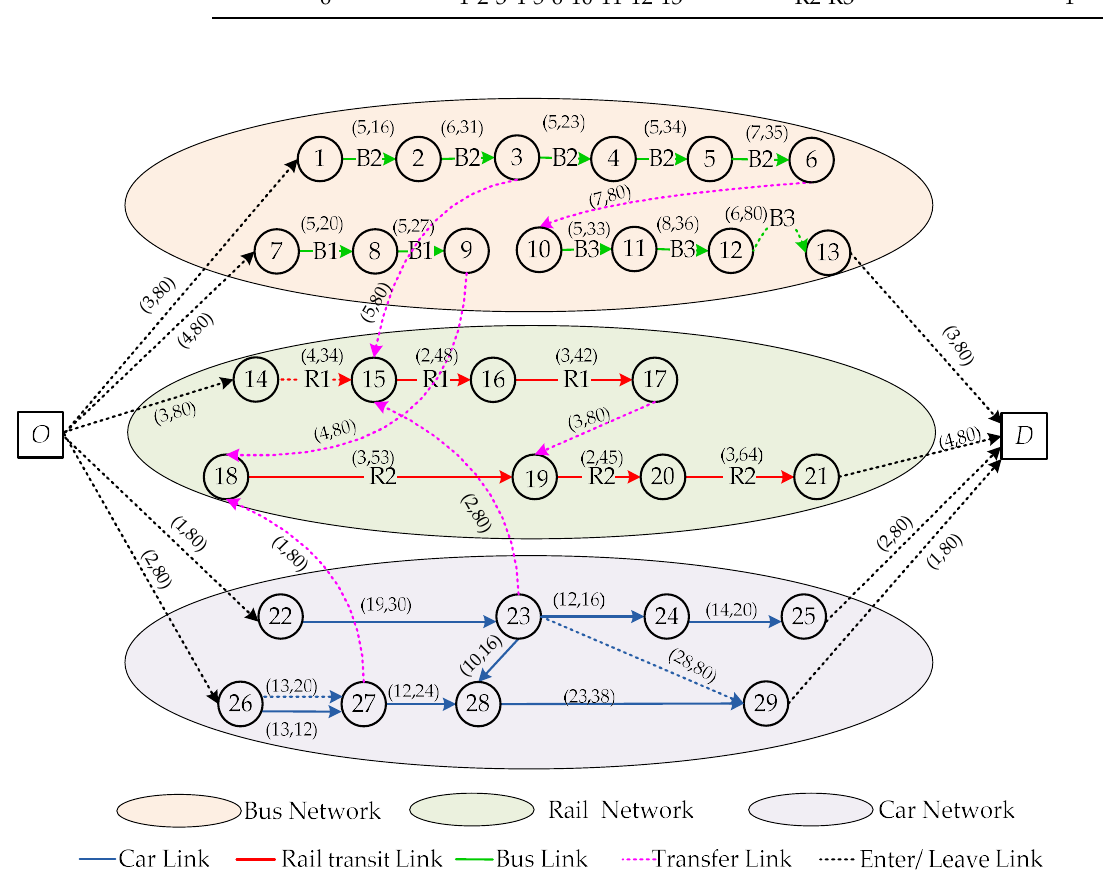
Figure 13. The generalized cost and capacity of each link in the super network topology.